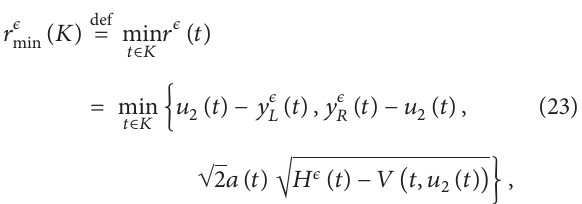
Figure 3: Solution of (27), (28), 𝜖 2 = 0.0224 on ⟨−2.45, 2.1⟩ (a); solution of (27), (28), 𝜖 2 = 0.0225 on ⟨−2.45, −1.25⟩